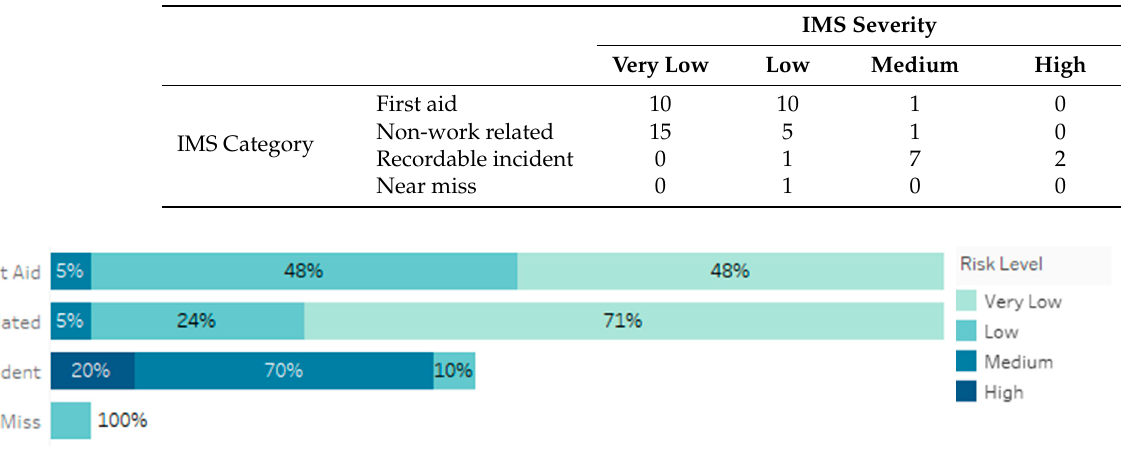
Figure 5. Percentage of injuries by IMS risk rating, coloured by actual insurance severity.